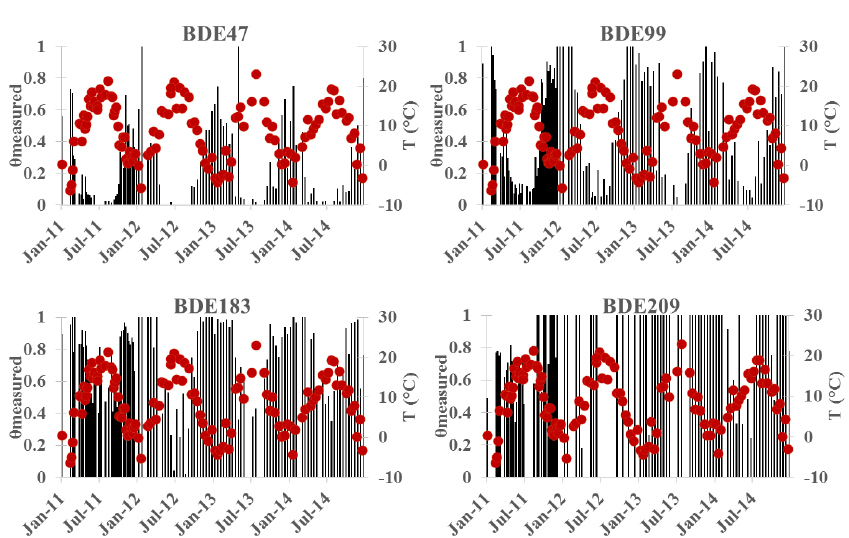
Figure 1. Time series of particulate fraction ( θ measured ) of selected PBDE congeners. Red dots represent the average temperature for each